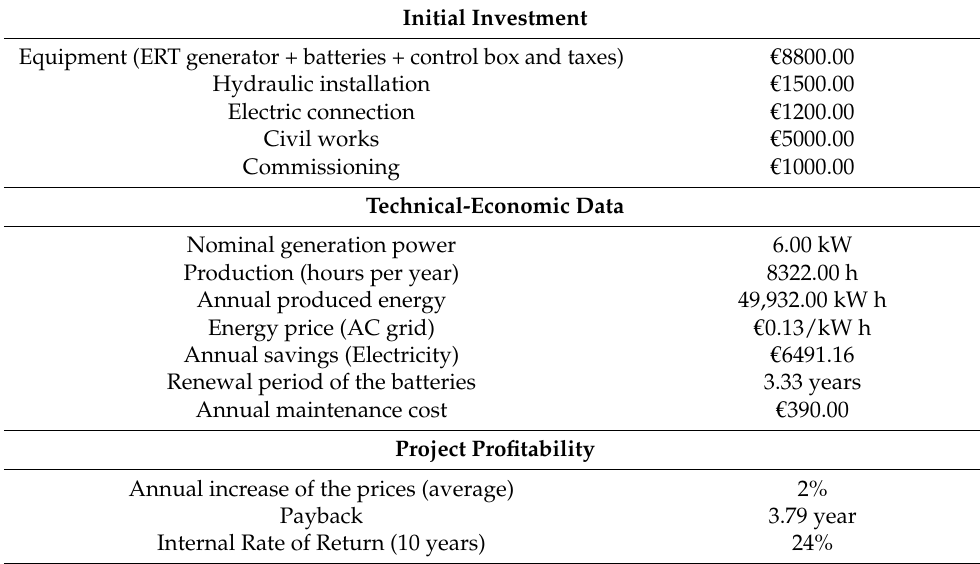
Annual increase of the prices